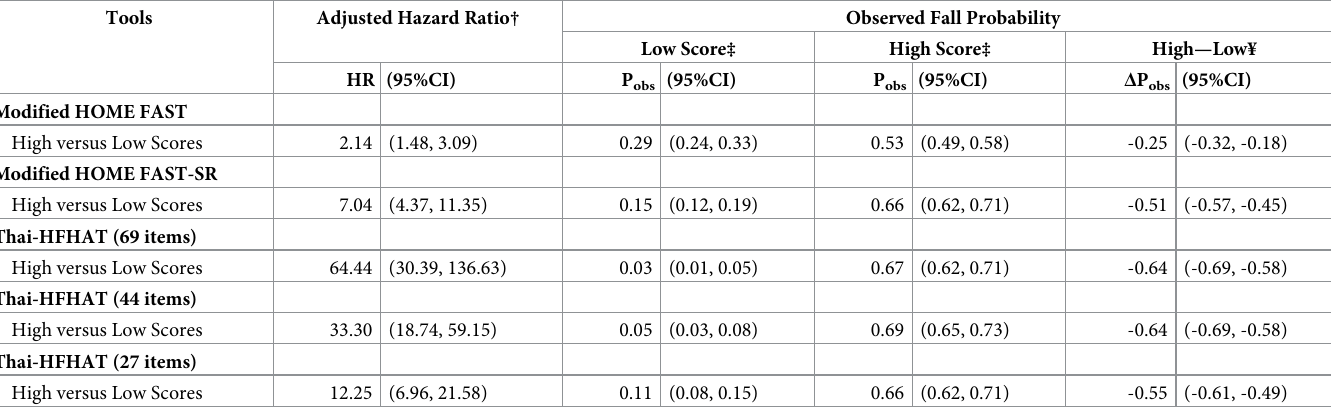
Table 5. Performance of the dichotomized scores of five home fall hazard assessment